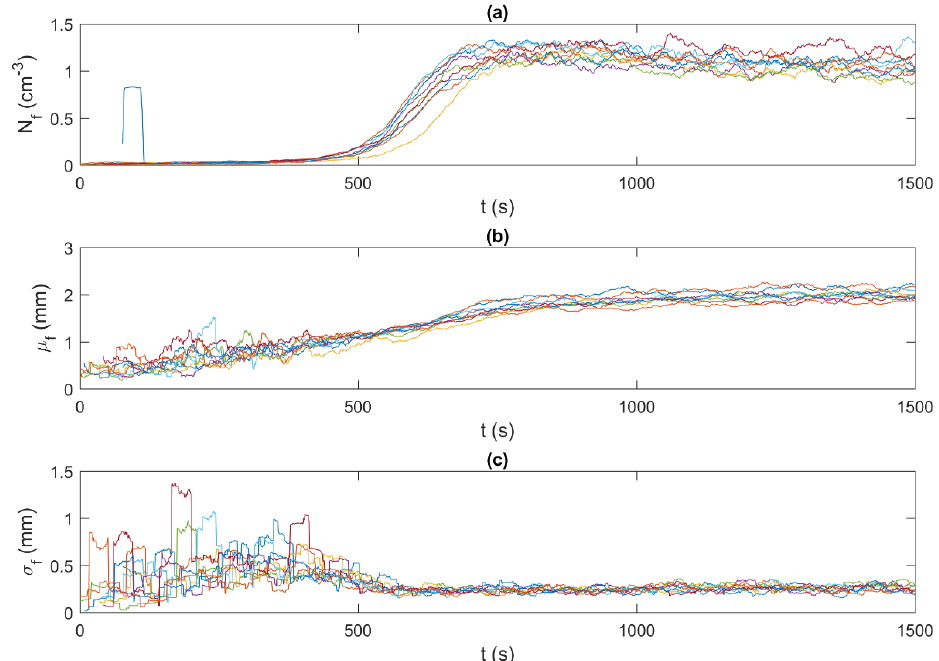
Figure 10. Time series of floc properties for all 15‰ experiments (shown in different colours). (a) N f , the number of flocs per unit volume (cm − 3 ); (b) µ f , the mean size of flocs (mm); and (c) σ f , the standard deviation of the size of flocs (mm). Note that the data were smoothed using a 35s moving